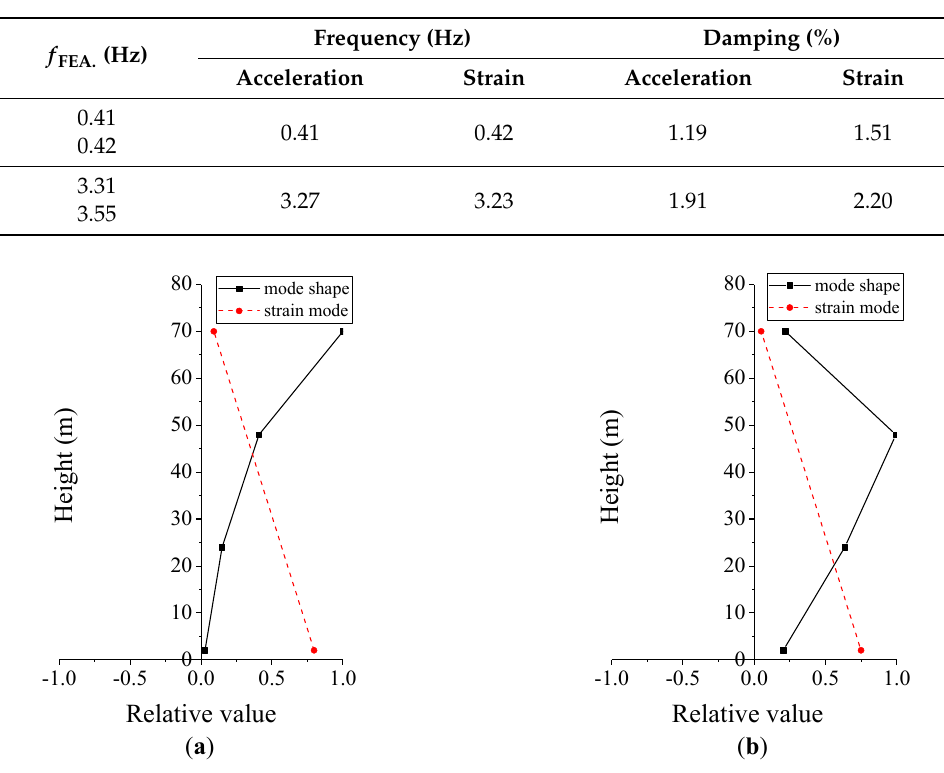
Table 4. Averaged values of the modal parameters identified by both the strain sensors and accelerometers.